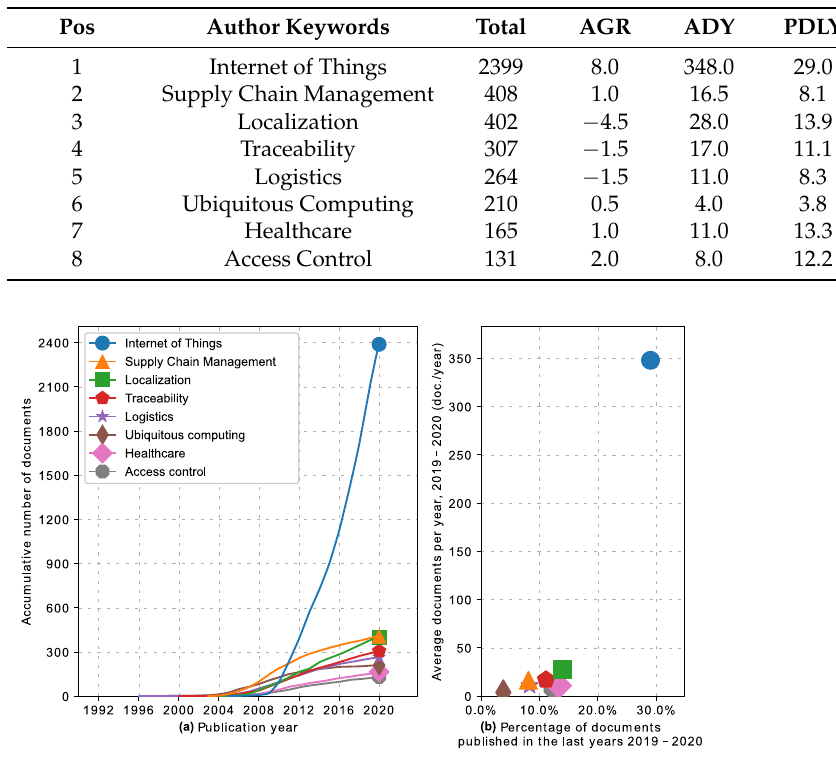
Figure 3. ( a ) Top applications, and number of publications by year. ( b ) Average number of publica- tions per year and percentage of documents published between 2019 and